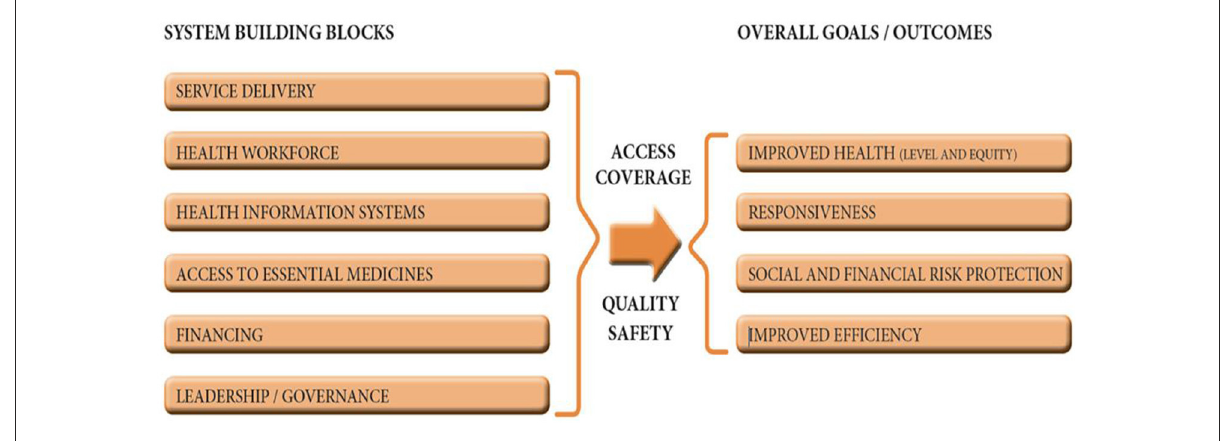
FIGURE1 The six building blocks of a health system